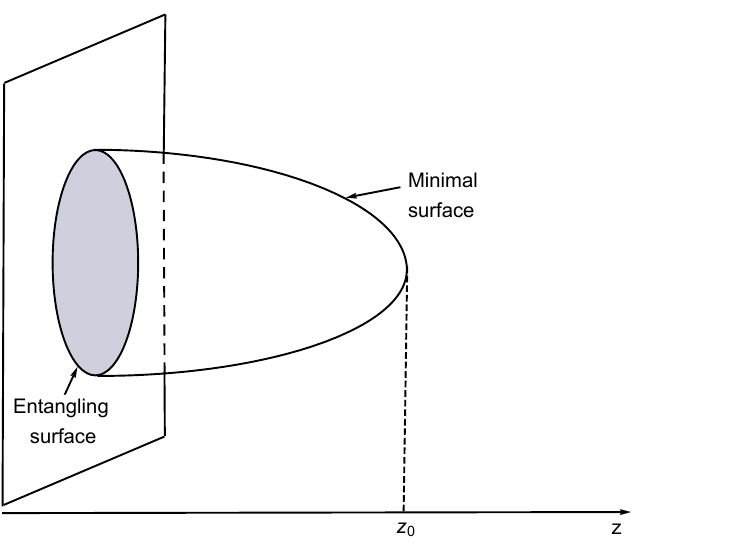
Figure 6. Cartoon of the minimal surface to compute the entanglement entropy in (cid:13)at space. The coordinate z is the holographic direction in conformal